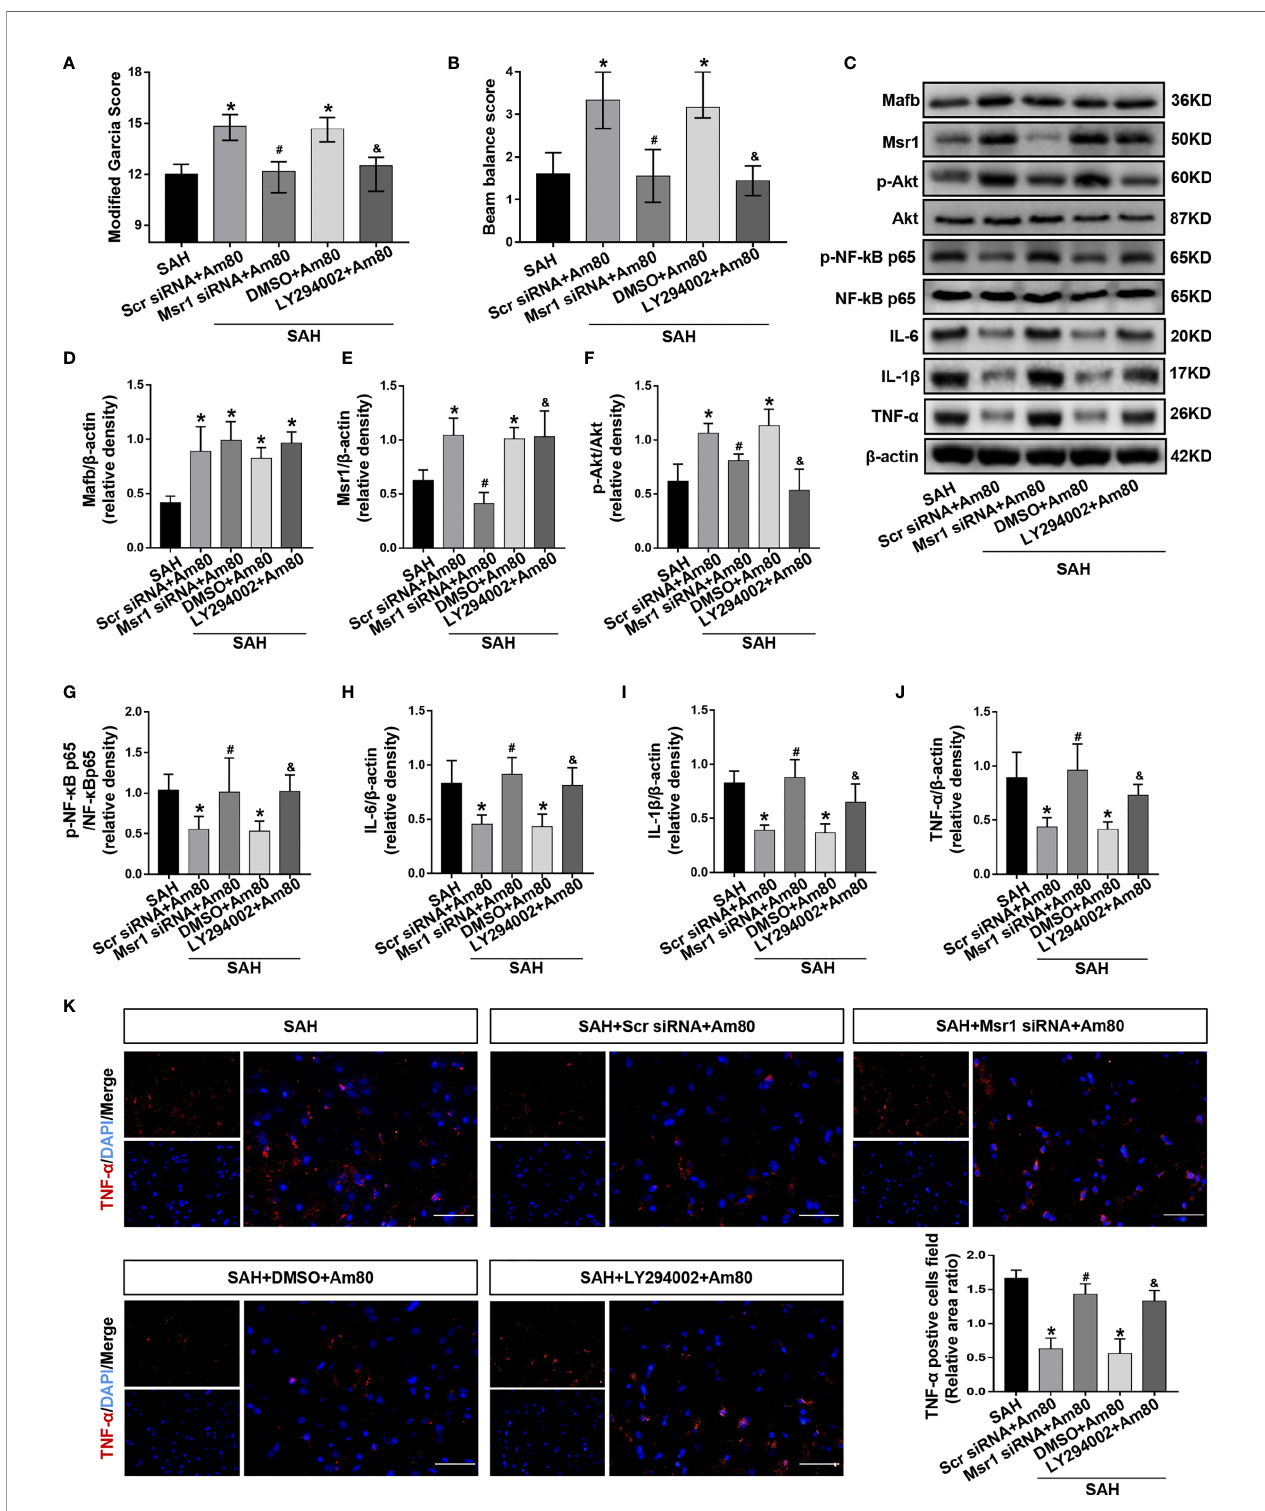
FIGURE 8 | Msr1 siRNA and LY294002 abolished the anti-neuroin fl ammation effects of Am80. (A, B) The neurological score were evaluated at 24 h after SAH. n = 6 per group. (C – J) Western blotting and quantitative analyses of the expression of Mafb, Msr1, p-Akt, p-NF-kB, IL-6 , IL-1 b and TNF- a . n = 6 per group. (K) Immuno fl uorescence staining and quantitative analyses of TNF- a -positive cells fi eld ratio. Scale bar = 50 m m. n=3 per group. * P < 0.05 vs SAH group; # P < 0.05 vs SAH+Scr siRNA+Am 80 group; & P < 0.05 vs SAH+DMSO+Am 80